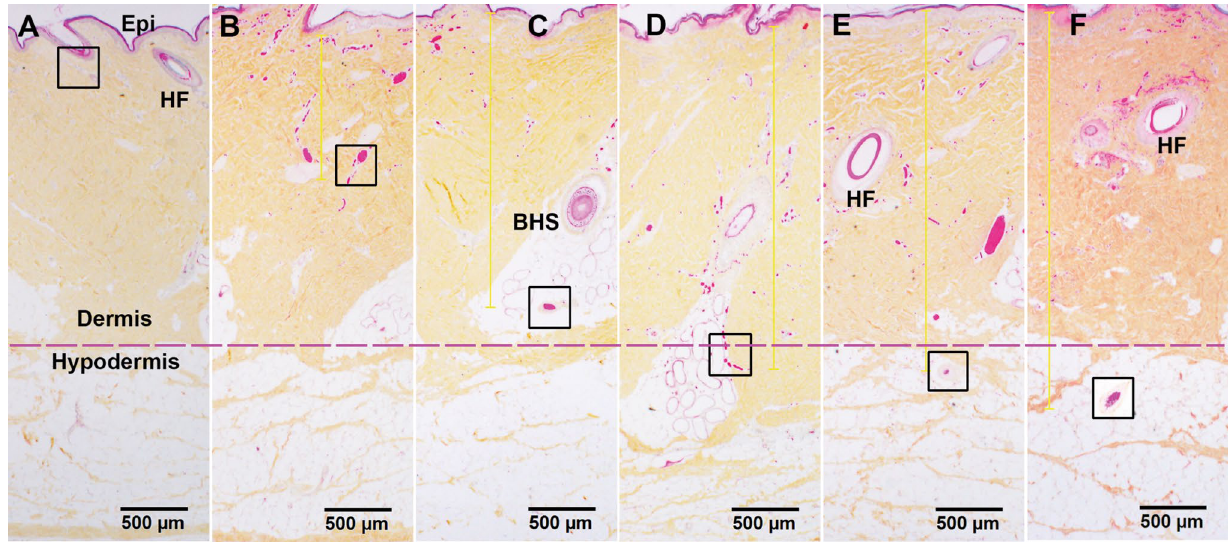
Figure 2. Representative HPS micrographs of burn site of porcine burn wounds harvested at 0 h (A), 0.5 h (B), 1 h (C), 2 h (D), 4 h (E), and 24 h (F) after injury. The box in each time point pinpoints the deepest vertical (from epidermal basement) levels of vessel occlusion at that time point. Higher power images of these boxes are presented in Fig. 3. Epi, epithelium; HF, hair follicle; BHS, the base of the hair shaft. Bar = 500 µm (A to F).